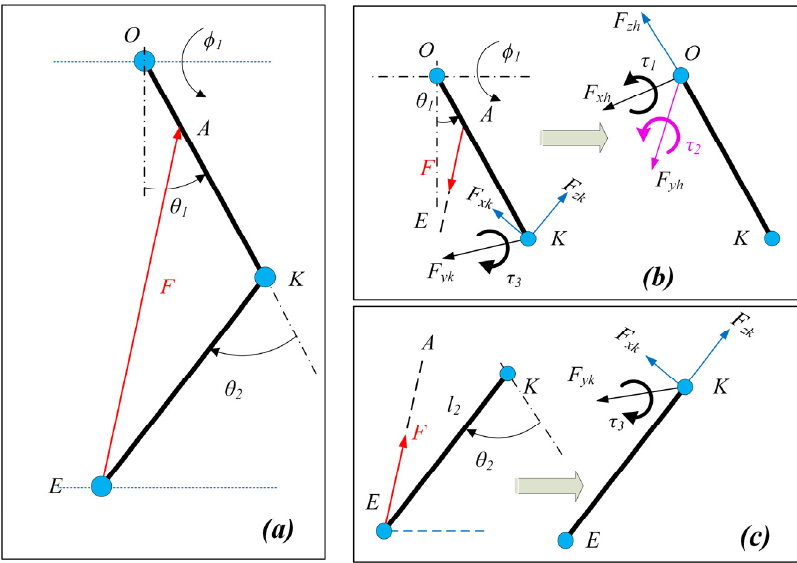
Figure 3. Cable force to joint moment mapping: ( a ) Two-link model with cable tension applied from thigh to shank, ( b ) Equivalent joint moment and component forces acting at the hip joint, and ( c ) Equivalent joint moment and component forces acting at the knee joint,.